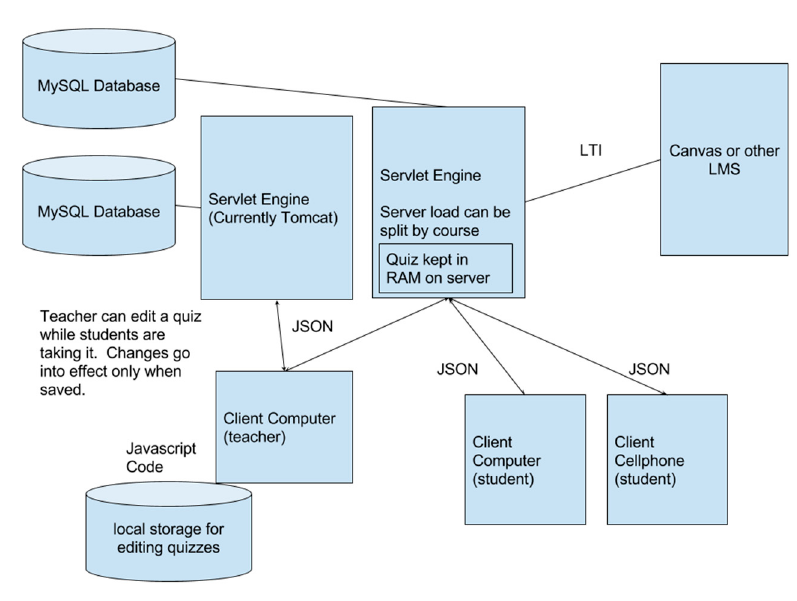
Figure 1. System Architecture of